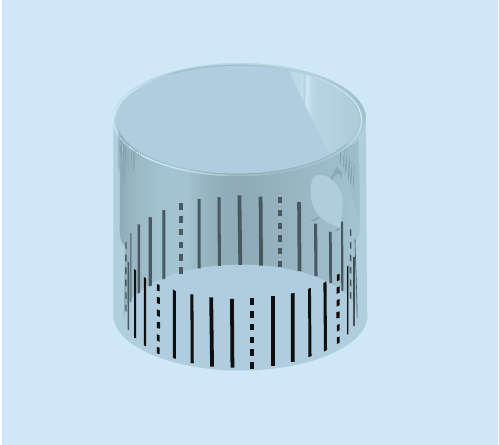
Figure 1: The calibrated hood was fabricated by attaching a graded plastic film to the inner circumference of the transparent hood. The calibrations consisted of unbroken lines marked on the plastic film at 1 mm intervals and broken lines at 5mm